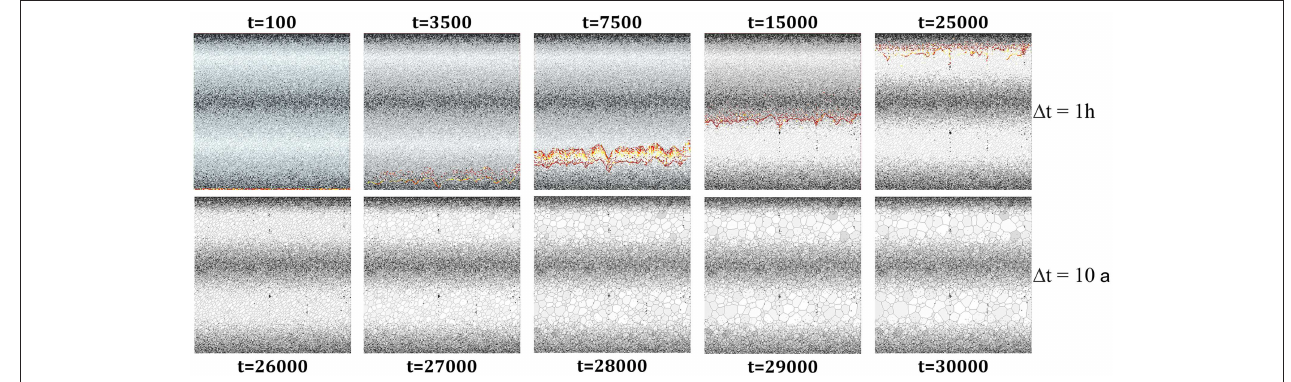
FIGURE 8 | Simulation of the zebra pattern formation by combining the simulation of the dolomitization and the grain growth. Both simulated processes redistribute the initial impurity scatter. The bifurcation is achieved because the initial set graded bedding distribution of particle size is superimposed by the size-dependent shift of the reaction front. A secondary redistribution is then performed during the propagation of the grain boundaries.